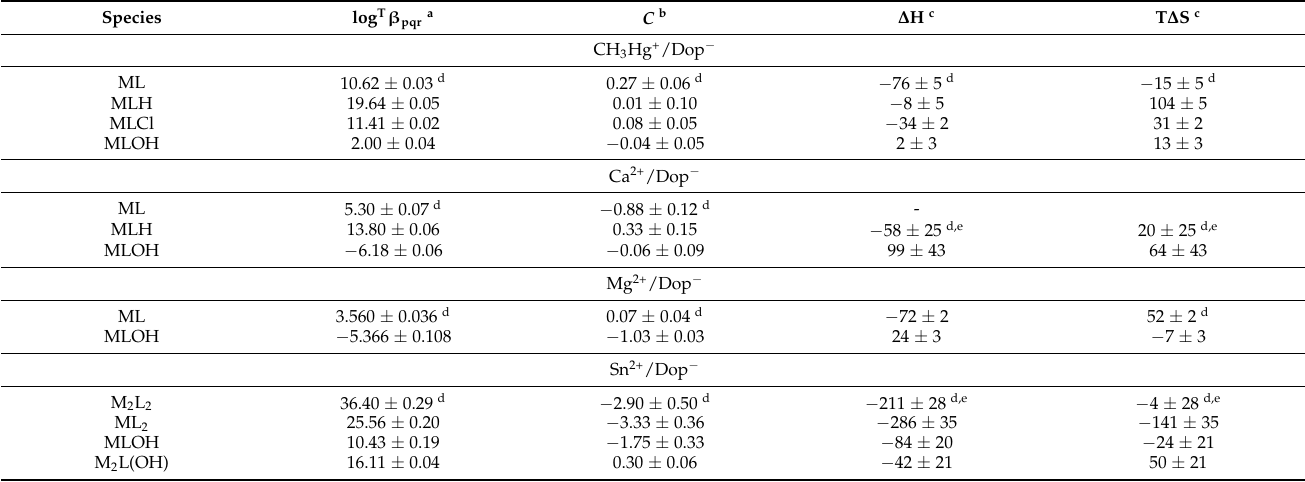
Table 9. Formation constants at infinite dilution and T = 298.15 K for the M n+ /Dop − species and enthalpy and entropy change